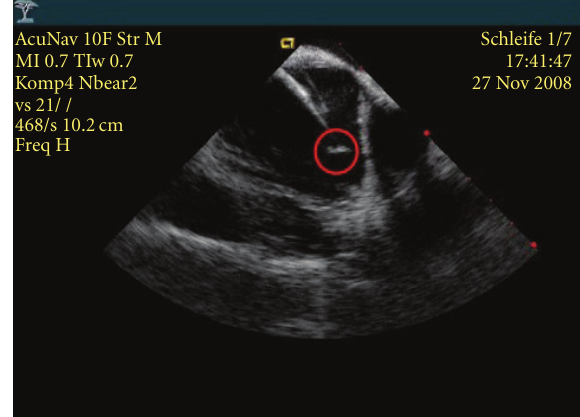
Figure 1: The circular mapping catheter can clearly be visualized in the antrum of the left superior pulmonary vein. Attached to the inferior part of the ring of electrodes, a mobile thrombus can clearly be seen (encircled). Immediately measured ACT was 289s.